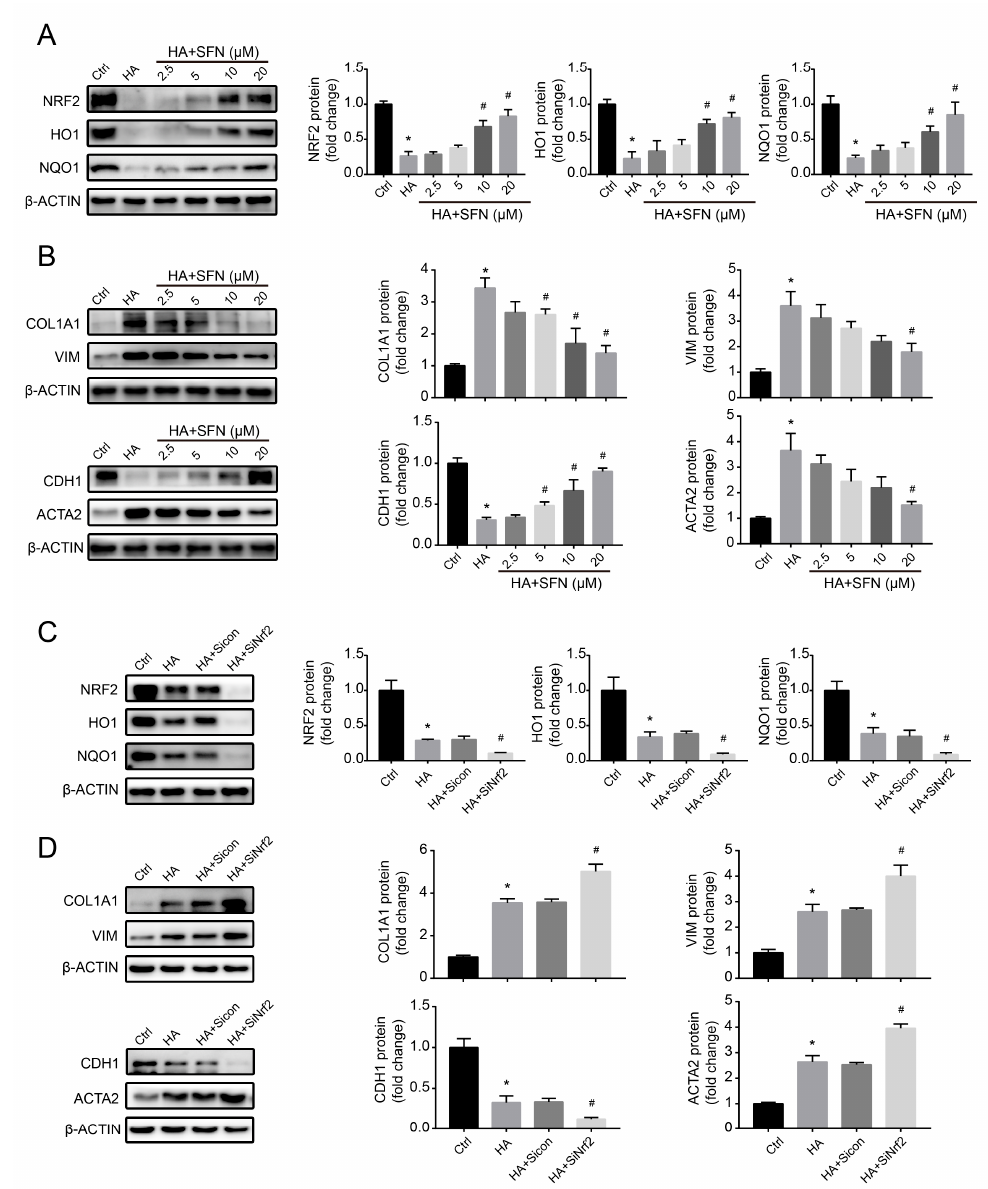
Figure 5. Role of nuclear factor erythroid 2-related factor 2 (NRF2) in hippuric acid (HA)-induced fibrotic gene expression in HK-2 cells. ( A ) Levels of protein expression of NRF2, heme oxygenase-1 (HO1), and NAD(P)H quinone dehydrogenase (NQO1) in cells pretreated with 0–20 µM sulforaphane (SFN), followed by treatment with 1000 µM HA. ( B ) Levels of protein expression of collagen-I (COL1A1), vimentin (VIM), E-cadherin (CDH1), and alpha-smooth muscle actin (ACTA2) in cells pretreated with 0–20 µM SFN, followed by treatment with 1000 µM HA. ( C ) Levels of protein expression of NRF2, HO1, and NQO1 after cell transfection with the control or NRF2 -specific small interfering RNA (siRNA), followed by treatment with 1000 µM HA. ( D ) Levels of protein expression of COL1A1, VIM, CDH1, and ACTA2 after cell transfection with the control or NRF2 -specific siRNA, followed by treatment with 1000 µM HA. Quantification was performed by densitometry. Data are presented as the mean ± standard deviation. * p < 0.05 vs. control (Ctrl) cells; # p < 0.05 vs. cells treated with HA only or HA + control siRNA. Experiments were repeated three times.